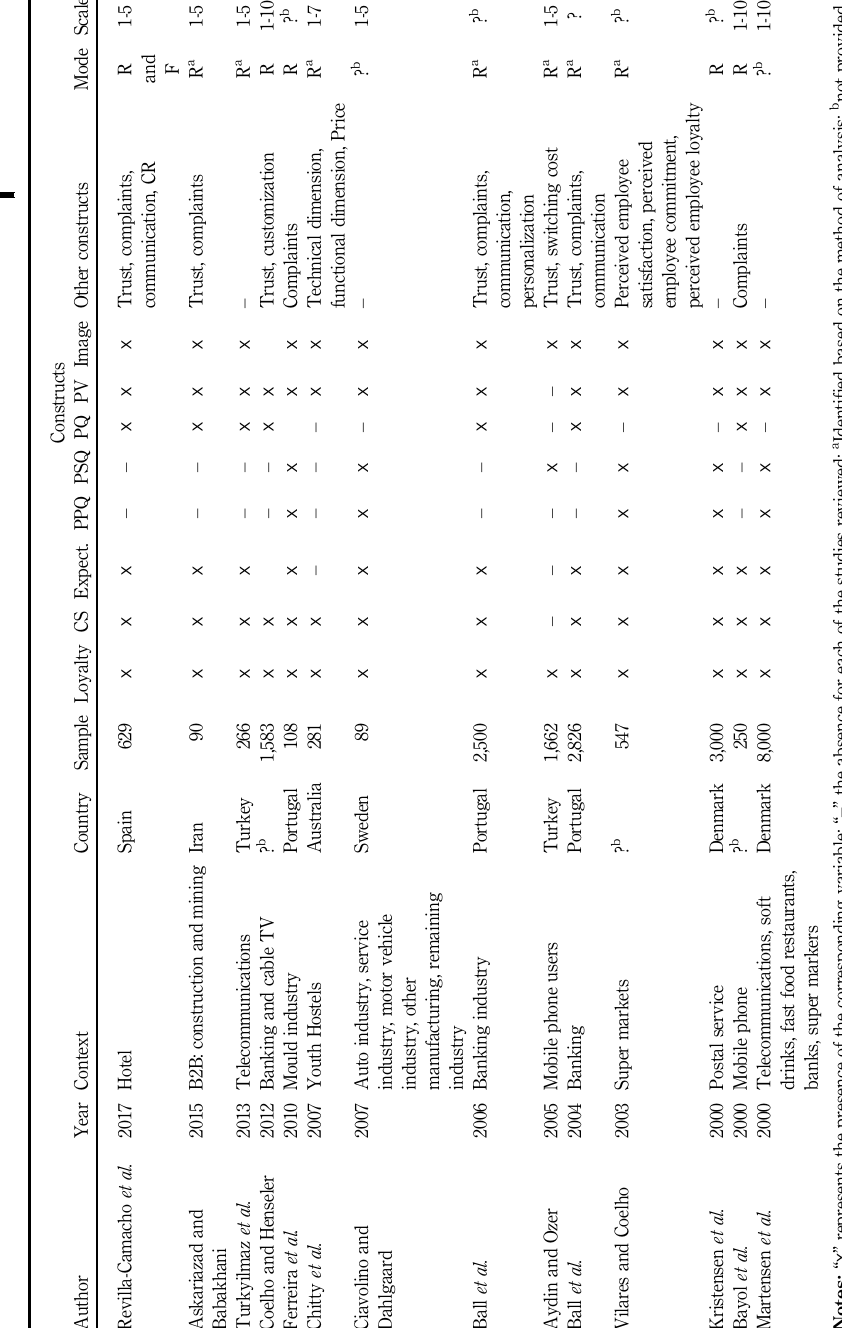
Table I. Methodology review of the ECSI